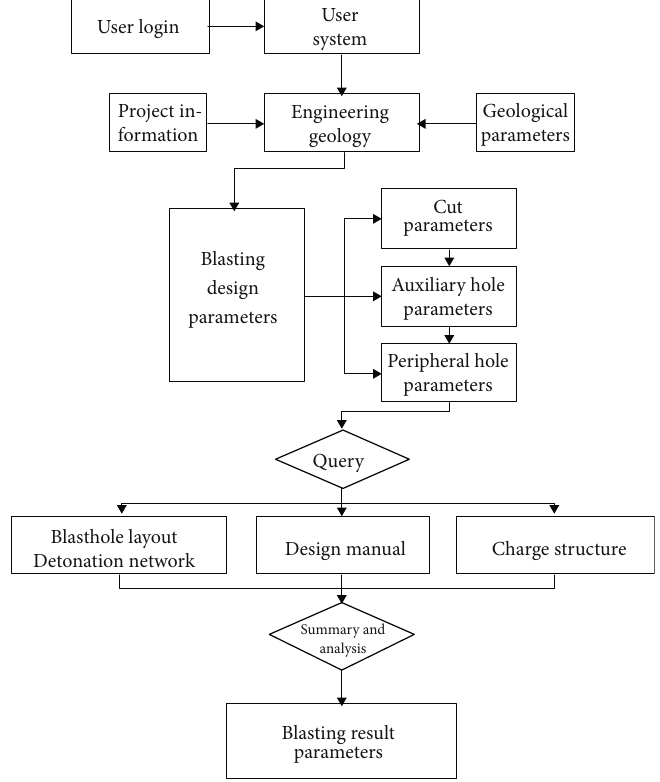
Figure 5: Data logic of intelligent design system for mine tunnel blasting based on